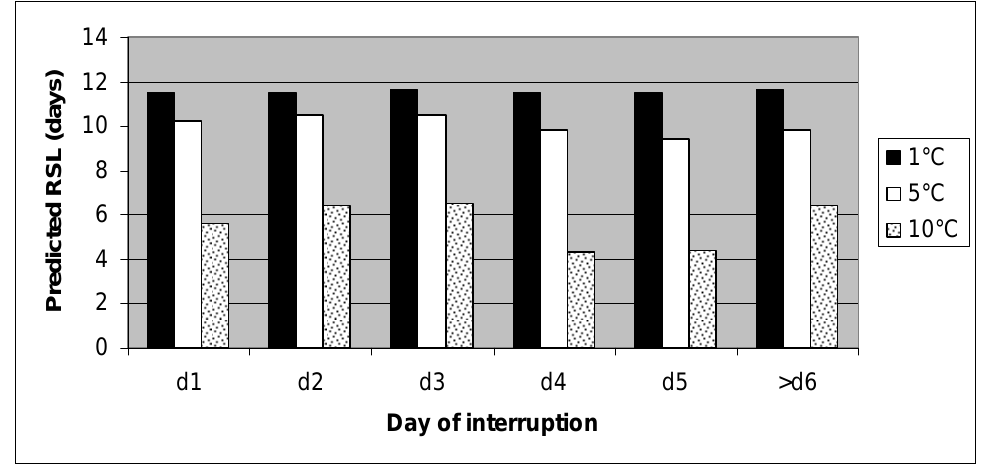
Figure 3. One-day interruption with 5°C or 10°C affected remaining shelf life (RSL) of 1°C stored living lettuce. On day 5, three sample cases which had storage temperature conditions of [1-1-1°C], [1-5-1°C], and [1-10-1°C] in sequence of [1d-3d-rest of